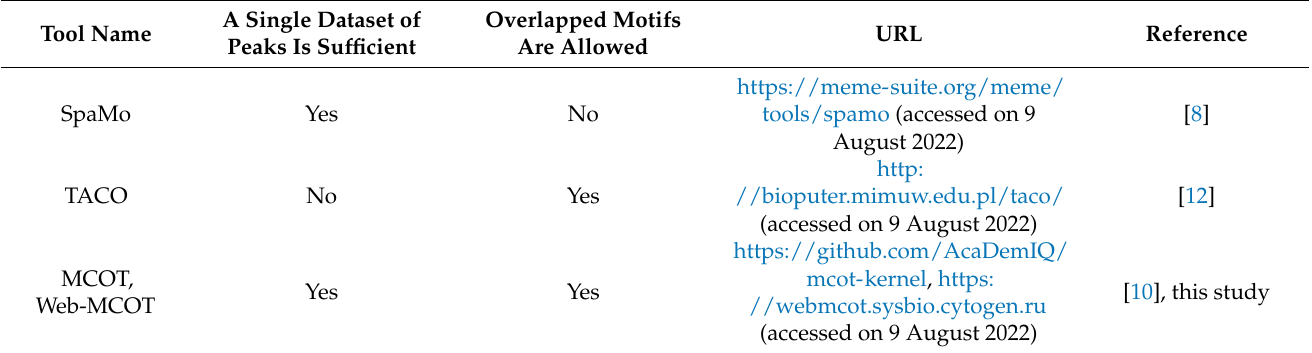
Table 1. Comparison of various tools for prediction of CEs in ChIP-seq